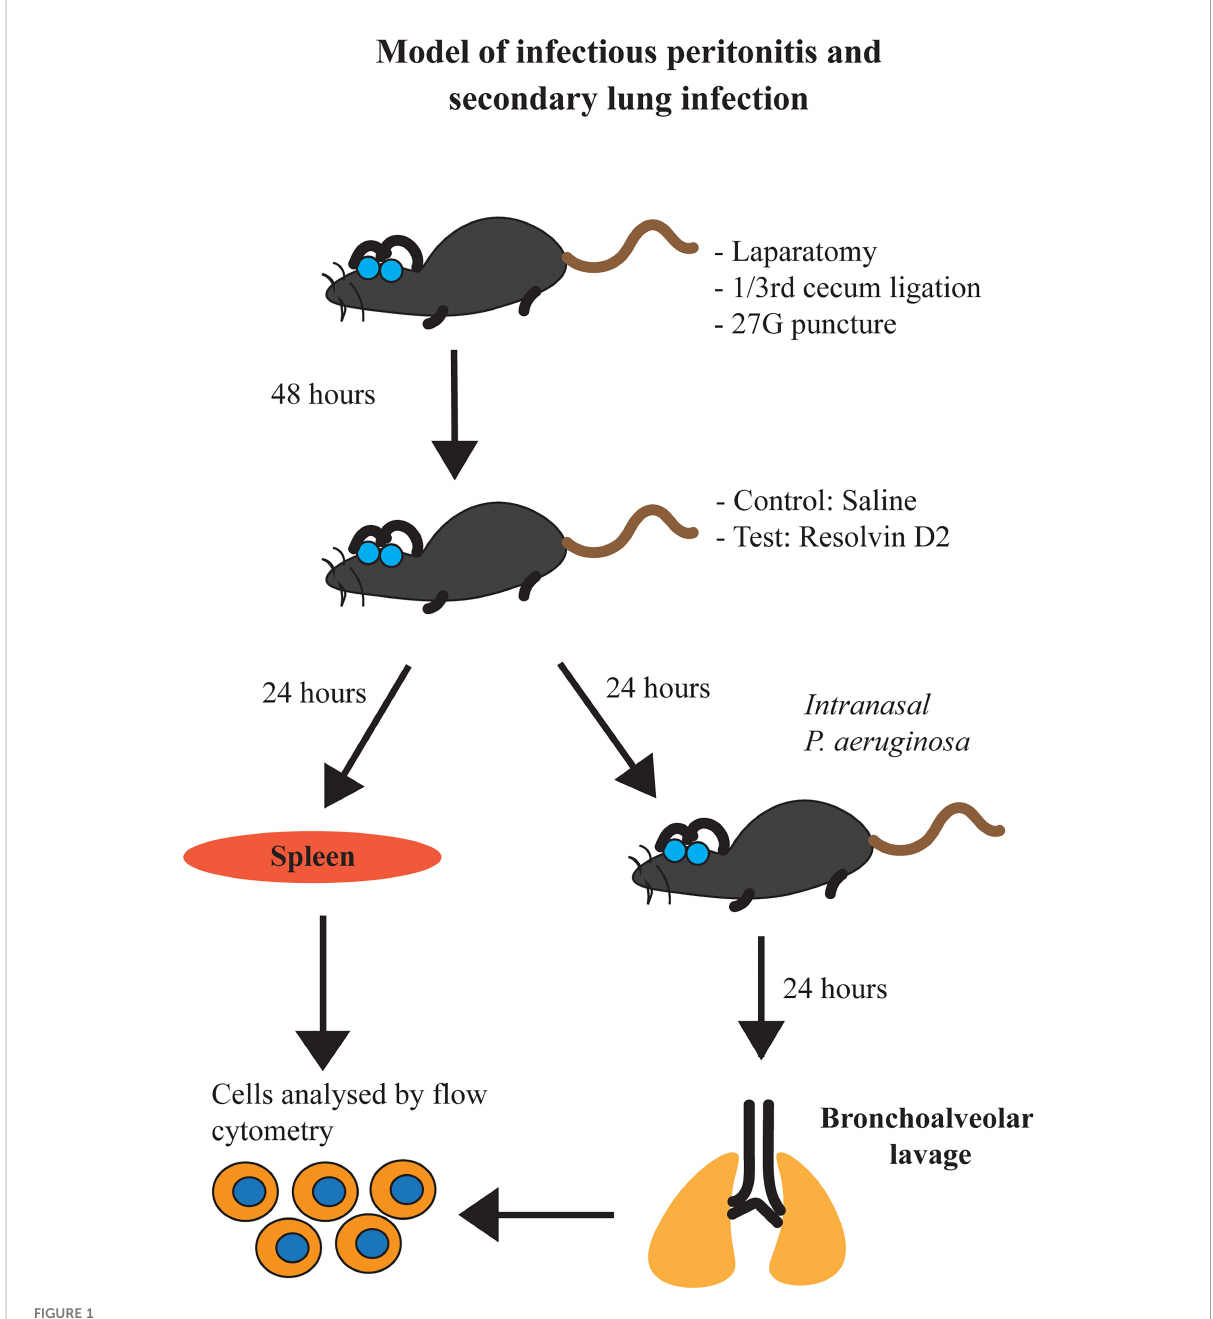
FIGURE 1 Schematic representation of our model of infectious peritonitis and secondary lung